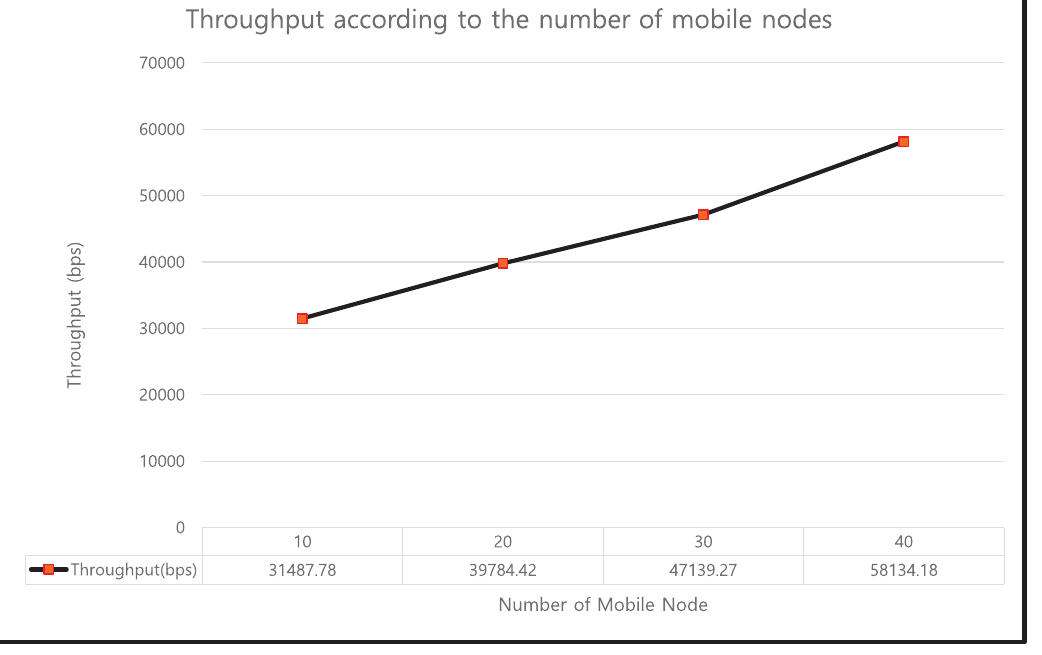
Fig 25. Throughput according to the number of mobile